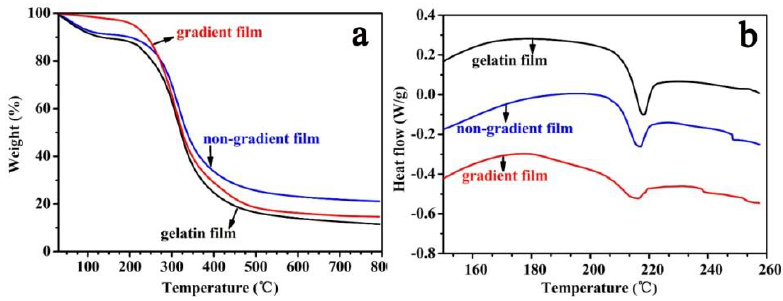
Figure 7. ( a ) TGA and ( b ) DSC curves of gradient, non-gradient and gelatin films.